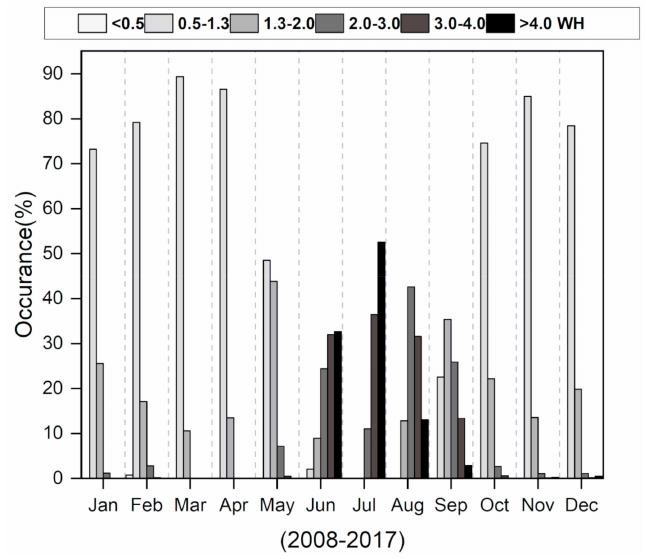
Figure 13. Wave (m) climatology of the Sindh Coastal zone with respect to the modern Beaufort scale